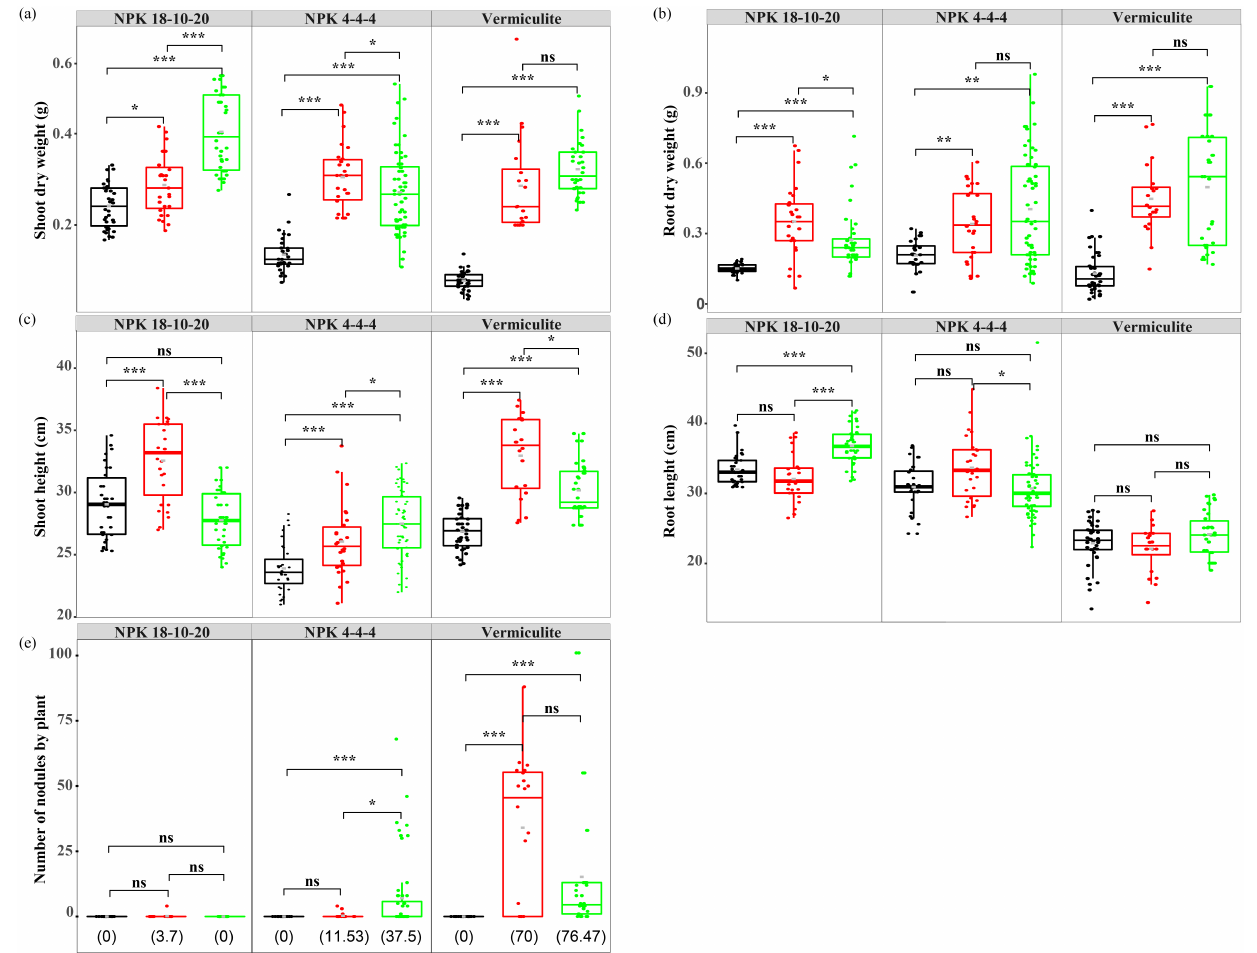
Figure 1. Phenotypic traits of uninoculated peas (black) and peas inoculated with Rhizobium leguminosarum (red) or Sphingomonas sediminicola (green) grown under N-rich (NPK = 18-10-20), N-limited (NPK = 4-4-4), and N-free (vermiculite) substrate. Plants were harvested at flowering (about 30 days post-inoculation). ( a ) Dry weight of shoots and ( b ) roots. ( c ) Shoot height and ( d ) root length. ( e ) Number of root nodules in plants grown under the three different N-fertilisation conditions. The percentage of nodulated plants is given in brackets. Statistical differences were based on Wilcoxon rank sum tests with Holm’s